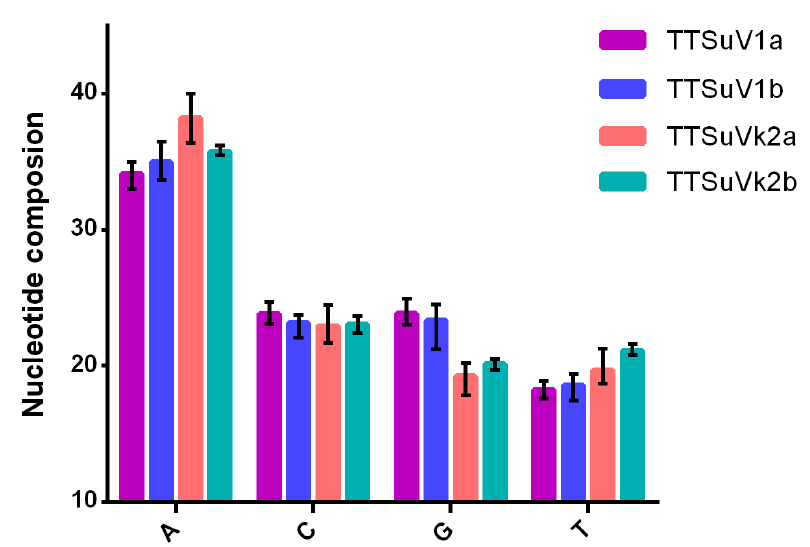
Figure 2. Nucleotide composition of TTSuV1a, TTSuV1b, TTSuVk2a, and TTSuVk2b. Nucleotides A, T, C, and G are represented by purple, blue, pink, and green, respectively.